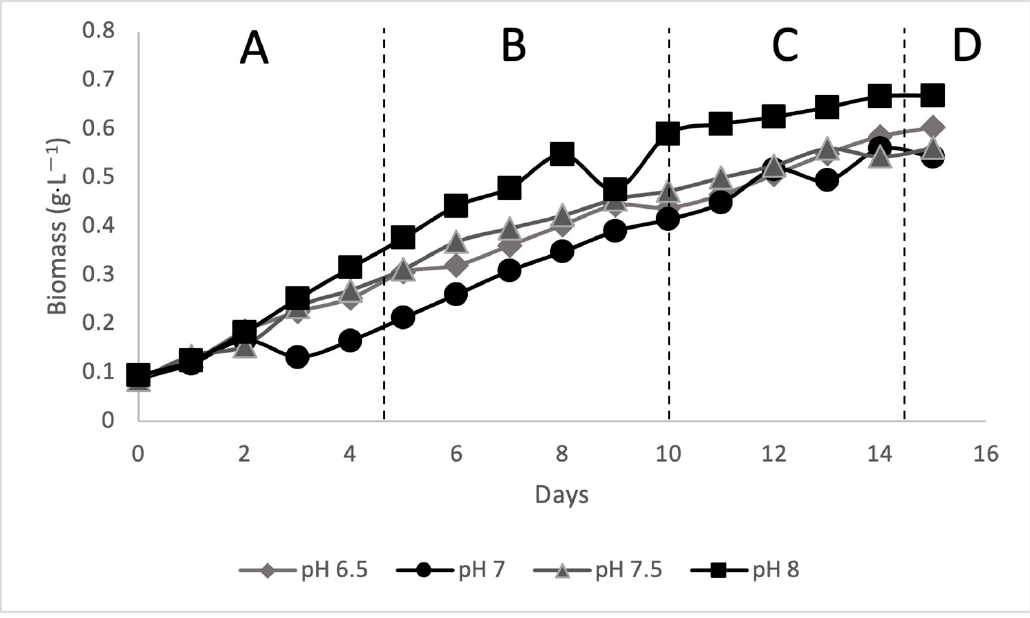
Microorganisms 2022 , 10 , x FOR PEER REVIEW Figure 2. The growth of cell biomass via batch bioreactor. Figure 2. The growth of cell biomass via batch bioreactor.